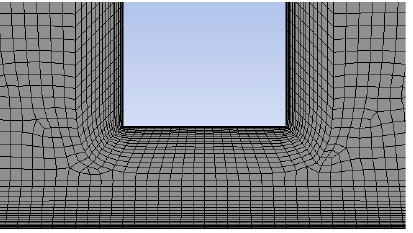
Figure 7. Illustrative grid used for calculations.